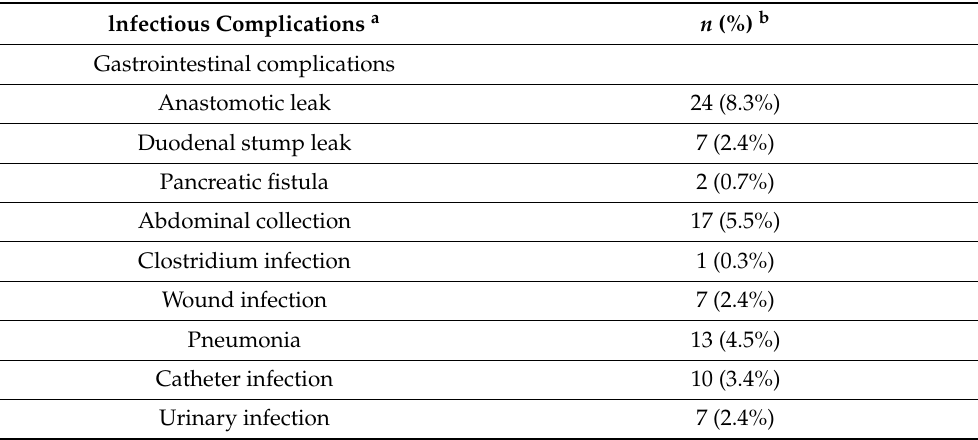
Table 2. Type of postoperative infectious complication, as defined according to the Gastrectomy Complications Consensus Group (GCCG) [29]. A total of 88 postoperative infectious complications in 81 patients.